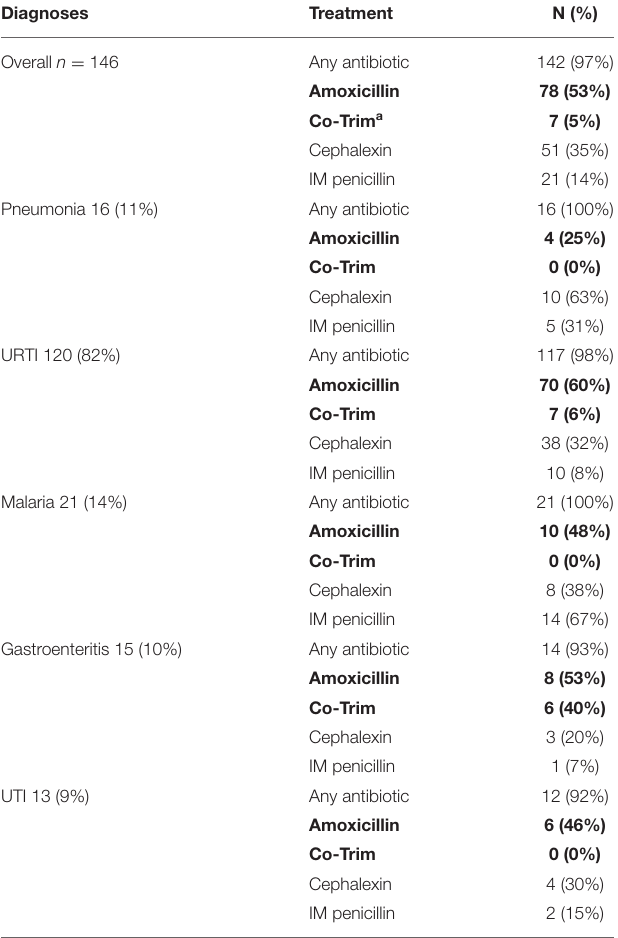
TABLE 4 | Provider diagnoses and antibiotics prescribed for patient meeting IMCI criteria for pneumonia.